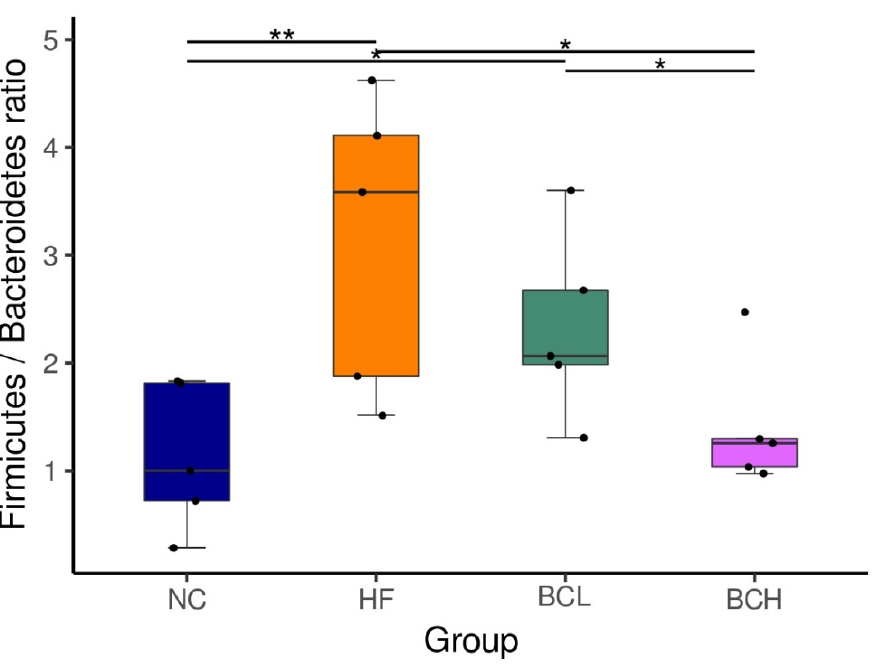
Figure 3. The ratio of Firmicutes to Bacteroidetes within rats fed chow diet (NC group), high-fat diet (HF group), high-fat diet + low dose of B. coagulan BACO-17 (7 log CFU/day) (BCL group), and high-fat diet + high dose of B. coagulan BACO-17 (9 log CFU/day) (BCH group) ( n = 5 per group). Levels of statistical significance are denoted as follows: *, p < 0.05, and **, p < 0.01.